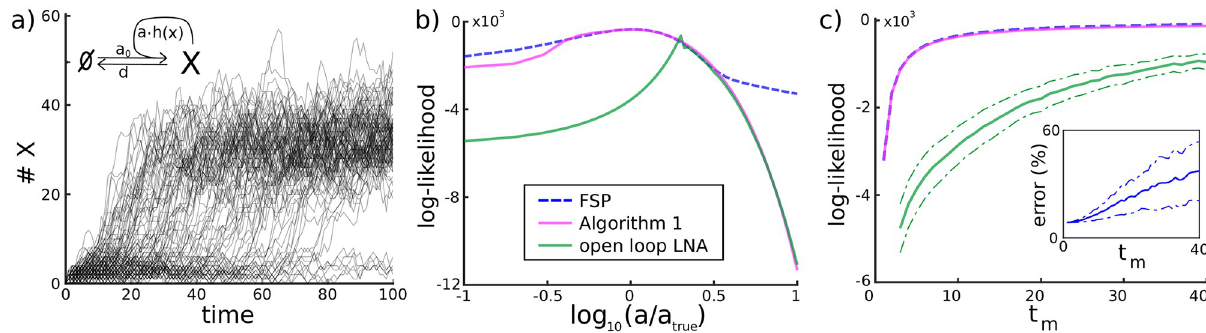
Fig 2. Accuracy of the likelihood approximation. A toy example of a reaction network (9) with a single chemical species and a positive feedback loop. a) N = 100 system trajectories obtained using Gillespie’s stochastic simulation algorithm. Molecule numbers of X are either very low, because only basal production of X is active at rate a 0 , or they switch to higher levels where the positive feedback is active. b) Data likelihood p ( y | θ ) for a single cell for the = 10 as a function of θ = a calculated using different approaches. Blue dashed: true data likelihood up to very distance between measurement times t m small errors obtained by FSP with a large truncation set. Purple: approximation using Algorithm 1. Green: approximation based on open loop use of the LNA. c) Mean ± one standard deviation of data likelihood p ð y j y Þ averaged over N = 100 cells as a function of the distance between measurement i ; t m times t . The colour coding is the same as in panel b. Inset : Relative error of Algorithm 1 as a function of t . Parameter values and initial condition for m m this system have been chosen as a 0 = 2, a = 8, k = 20, n = 5, d = 0.25, σ = 4, X (0) = 0, t S = 100, all in arbitrary or no units.